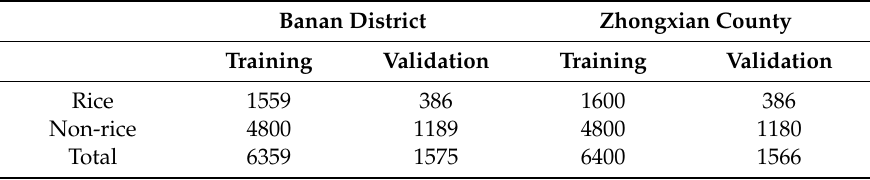
Table 1. The division of pure pixel samples in Banan District and Zhongxian